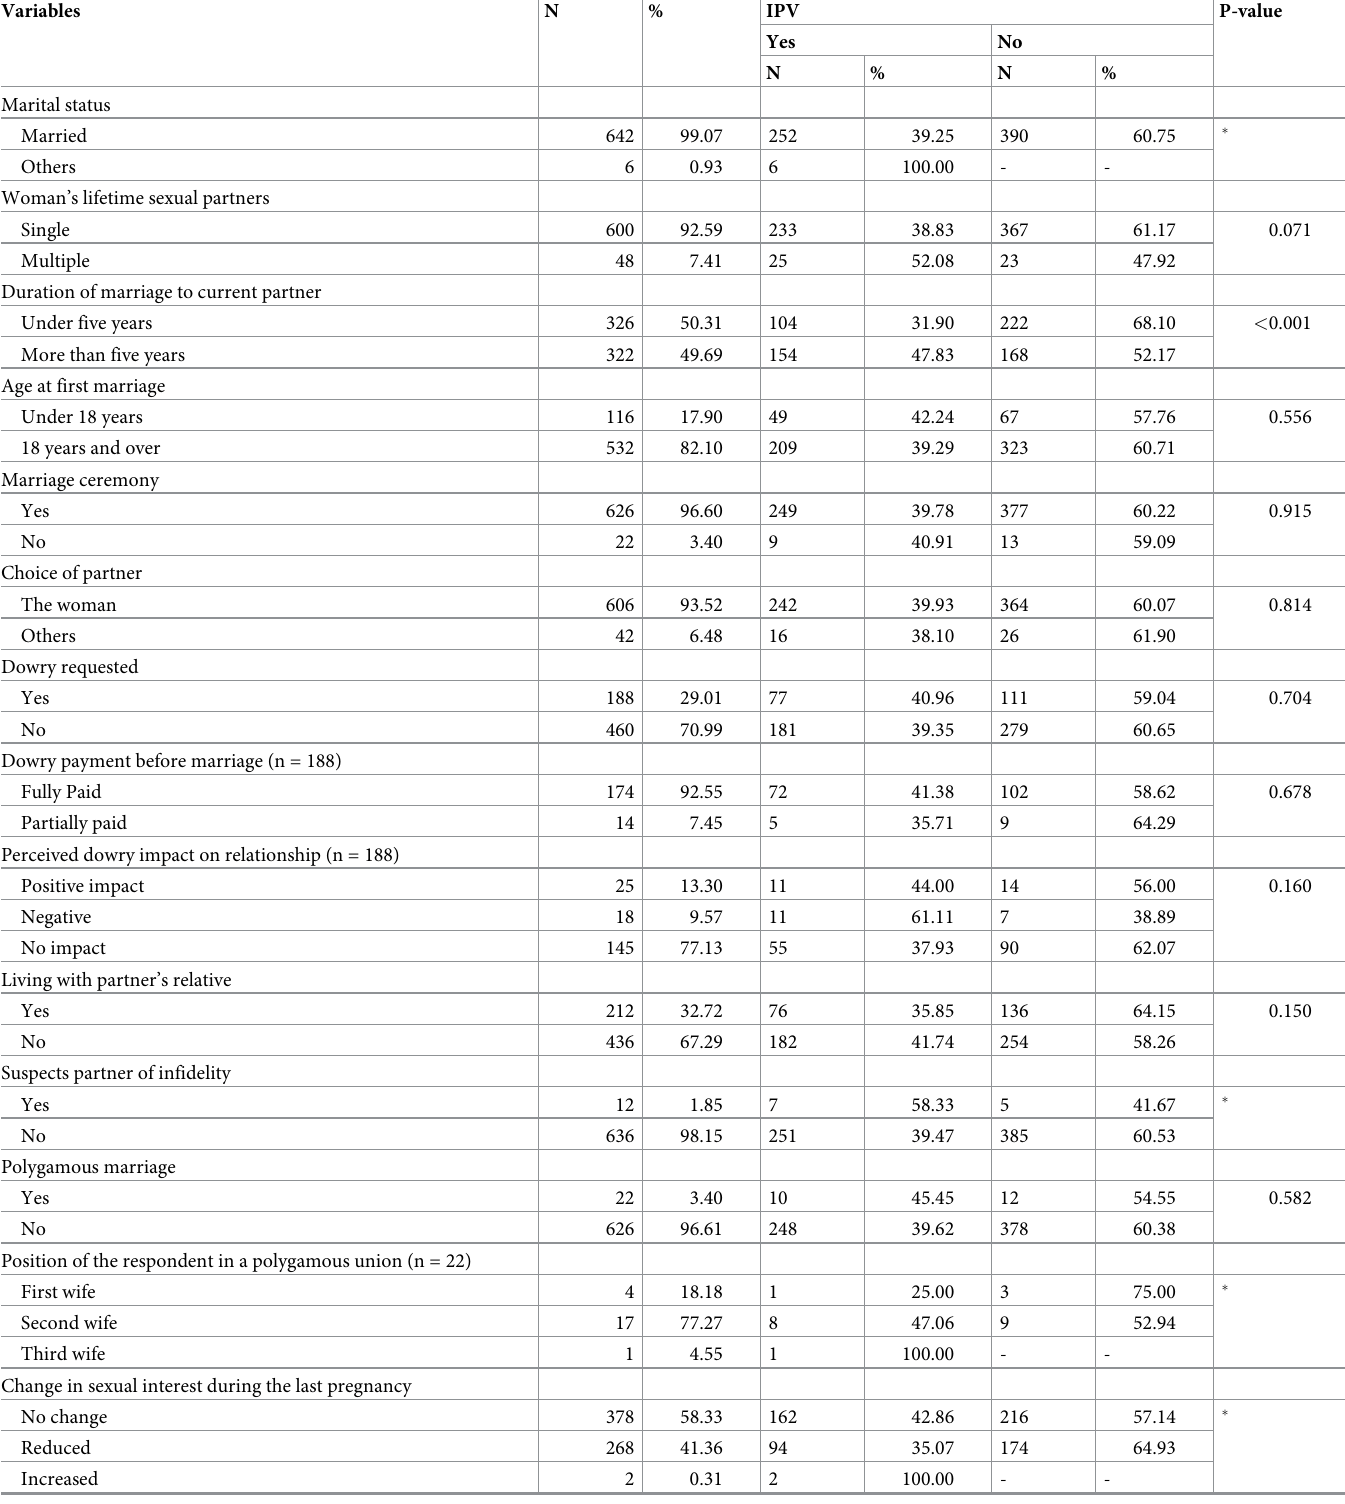
Table 3. Marital and behavioral factors of women who gave birth in public hospitals in Harari regional state, East Ethiopia, 2018–2019. Variables